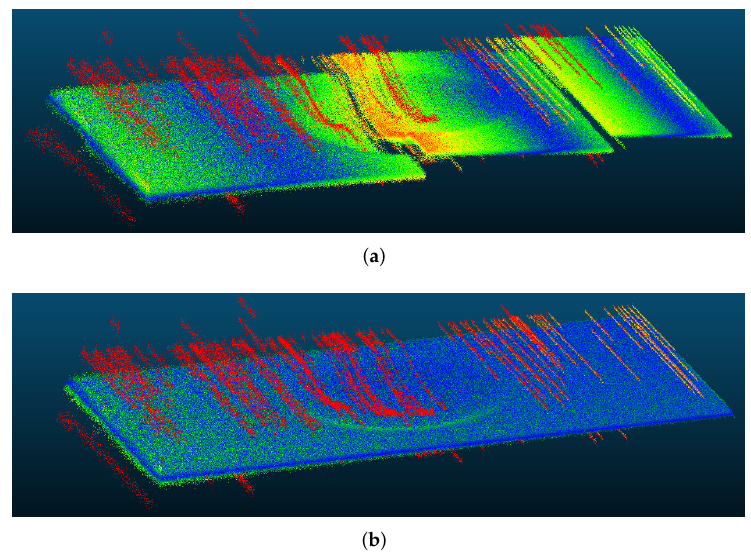
Figure 12. Comparison of 3D reconstruction of the simulated dent (as heatmap of MAE) using Itoh’s algorithm with the ( a ) direct mapping and the ( b ) virtual reference methods.